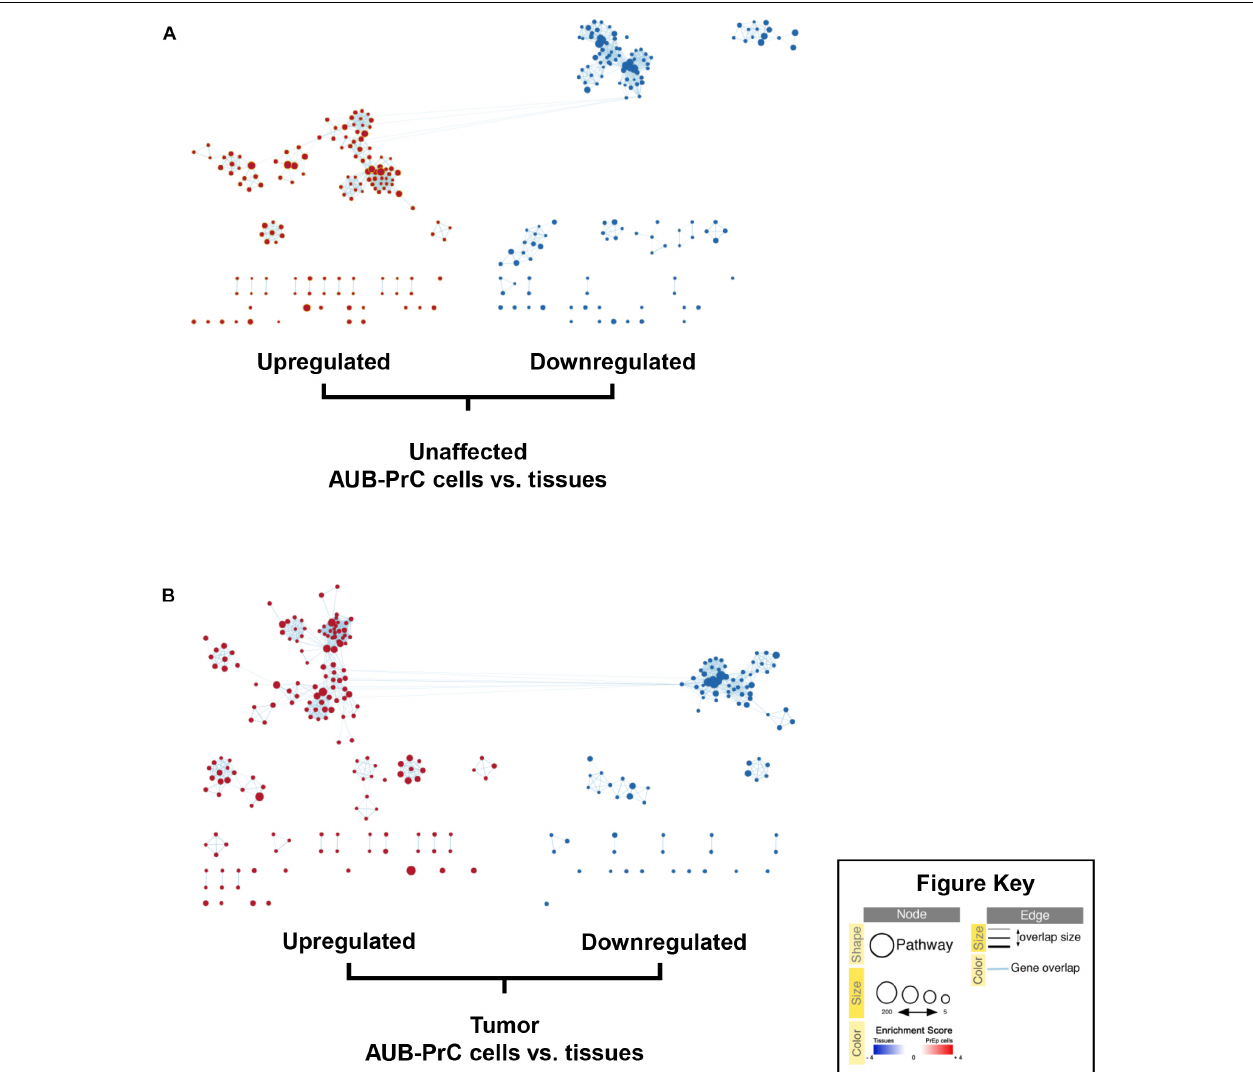
FIGURE 6 | Enrichment maps of pathways enriched in upregulated genes (red) and downregulated genes (blue) in AUB-PrC cells vs. tissues. Enrichment maps of pathways among prostate unaffected (A) and tumor (B) samples were built using EnrichmentMap analysis on Cytoscape 3.7.2 software. Each node (circle) represents a distinct pathway (red representing upregulated pathways and blue representing downregulated pathways), and edges (lines) represent the number of genes overlapping between two pathways, determined using the similarity